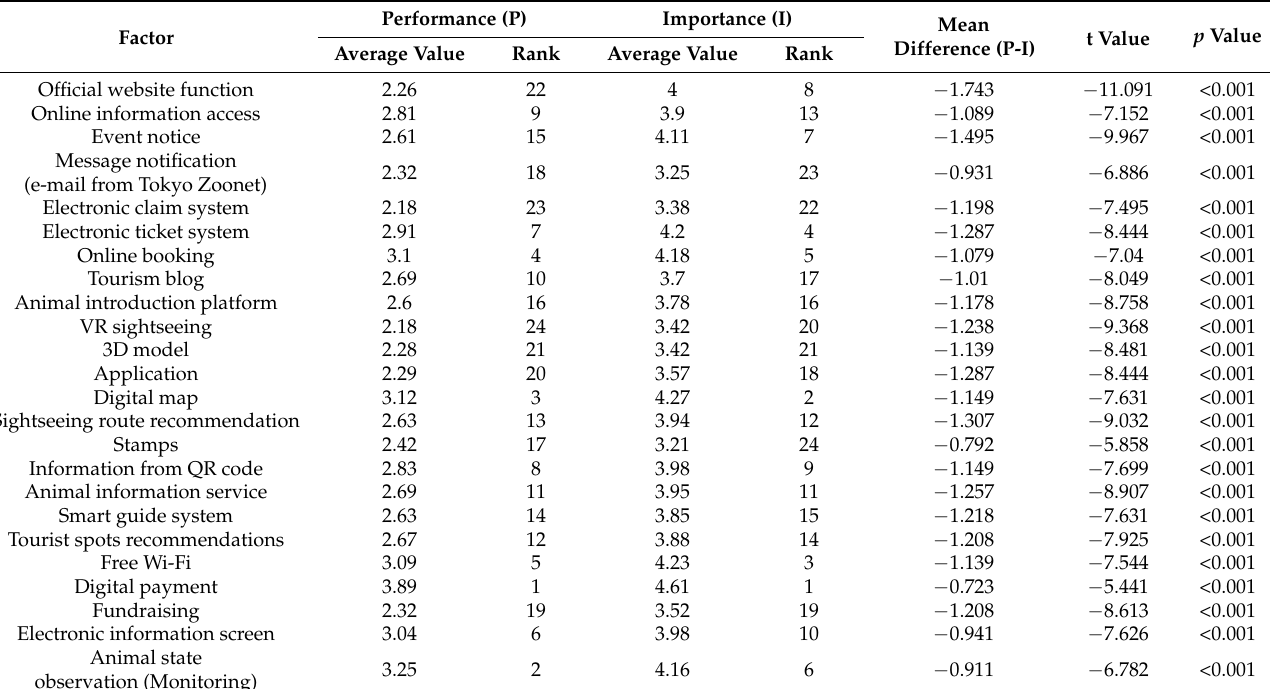
Table 16. Means and ranking of items at the second level of